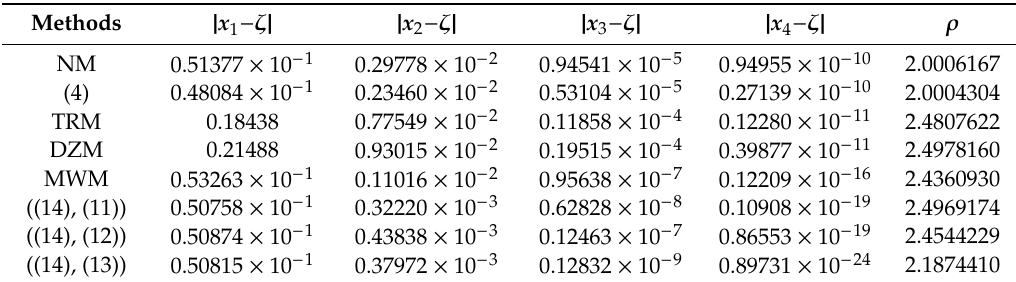
Table 7. Numerical results for function f 7 ( x ) .